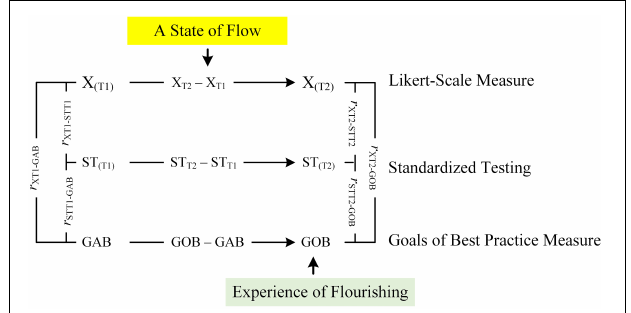
FIGURE 5 | Methodological conceptualization for consideration. T1 = Time 1, T2 = Time 2, r = correlation, GAB = Goal of Actual Best, GOB = Goal of Optimal Best, ST = Standardized testing, and X = Adaptive